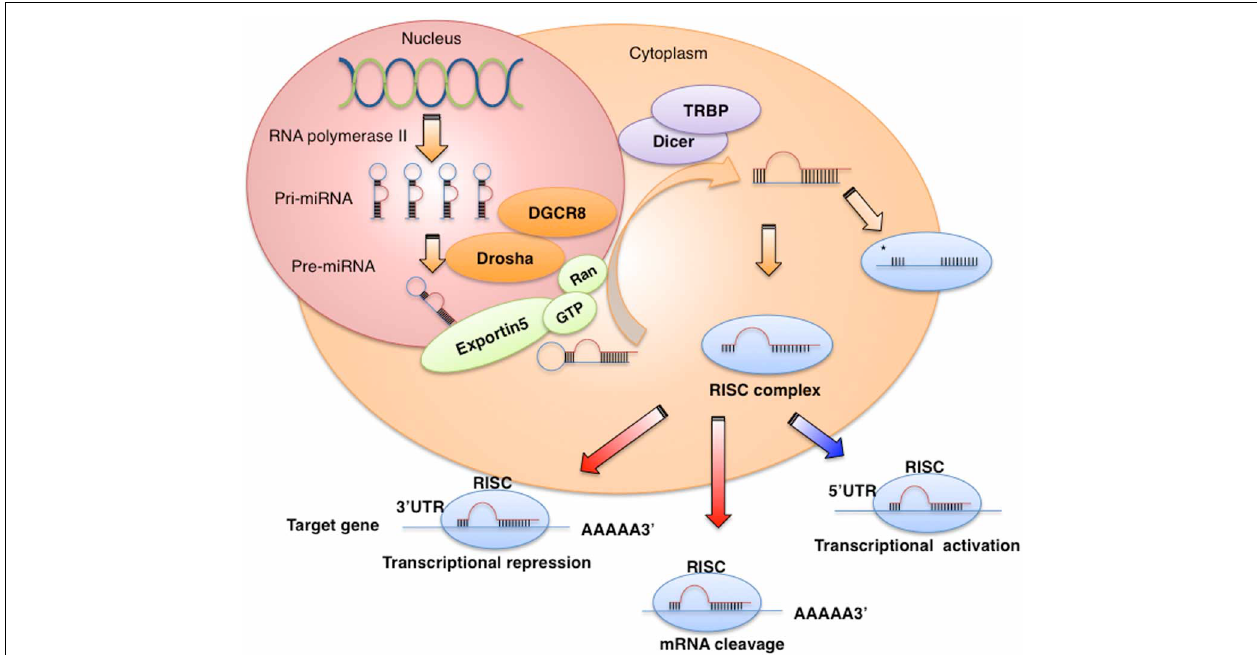
FIGURE 1 | miRNA biogenesis and function. miRNAs are transcribed by RNA polymerase II or III as pri-miRNA, and are processed in the nucleus by Drosha-DGCR8 into pre-miRNAs. The product of pri-miRNA cleavage, the pre-miRNA, is exported to the cytoplasm by exportin-5 and further cleaved in a complex composed of Dicer and TRBP. The functional strand of mature